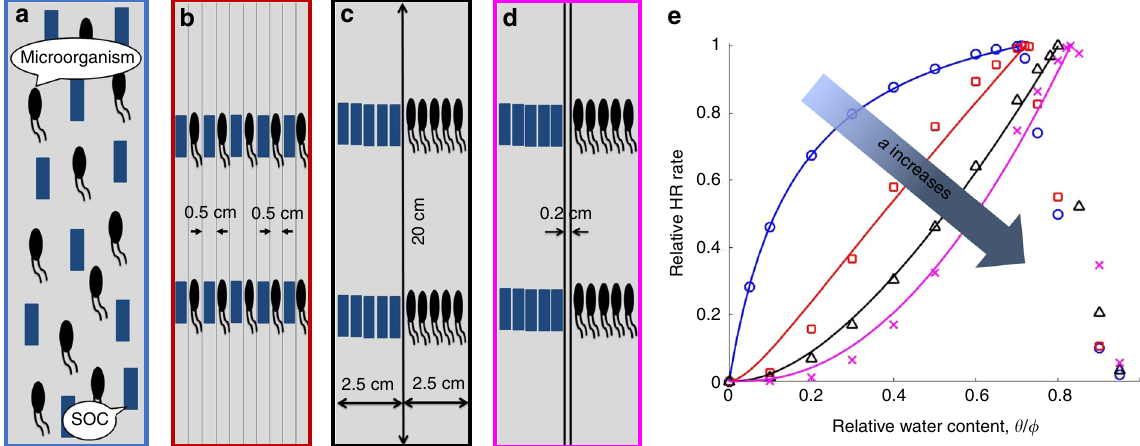
Fig. 2 Effects of the collocation between soil-adsorbed organic carbon (SOC) and microorganisms on the SOC – microorganism collocation factor a . SOC and microorganisms are a uniformly allocated in the simulated soil core, b allocated in ten connected sections, c allocated in two connected sections, and d allocated in two separate sections. e The relative heterotrophic respiration (HR) rates change with the relative water content for the different allocations of SOC and microorganisms in a – d . The blue circles, red squares, black triangles, and pink crosses represent the simulated HR – moisture relationships obtained by the microscale model (see Methods section) for the different collocations in a – d , respectively. The simulated HR rates were calculated by averaging the CO 2 fl ux at the soil – atmosphere interface of the soil core. The solid curves represent the moisture function, f m , with fi tted a , a = 0, 0.40, 0.72, and 0.97, via the linear least-square regression